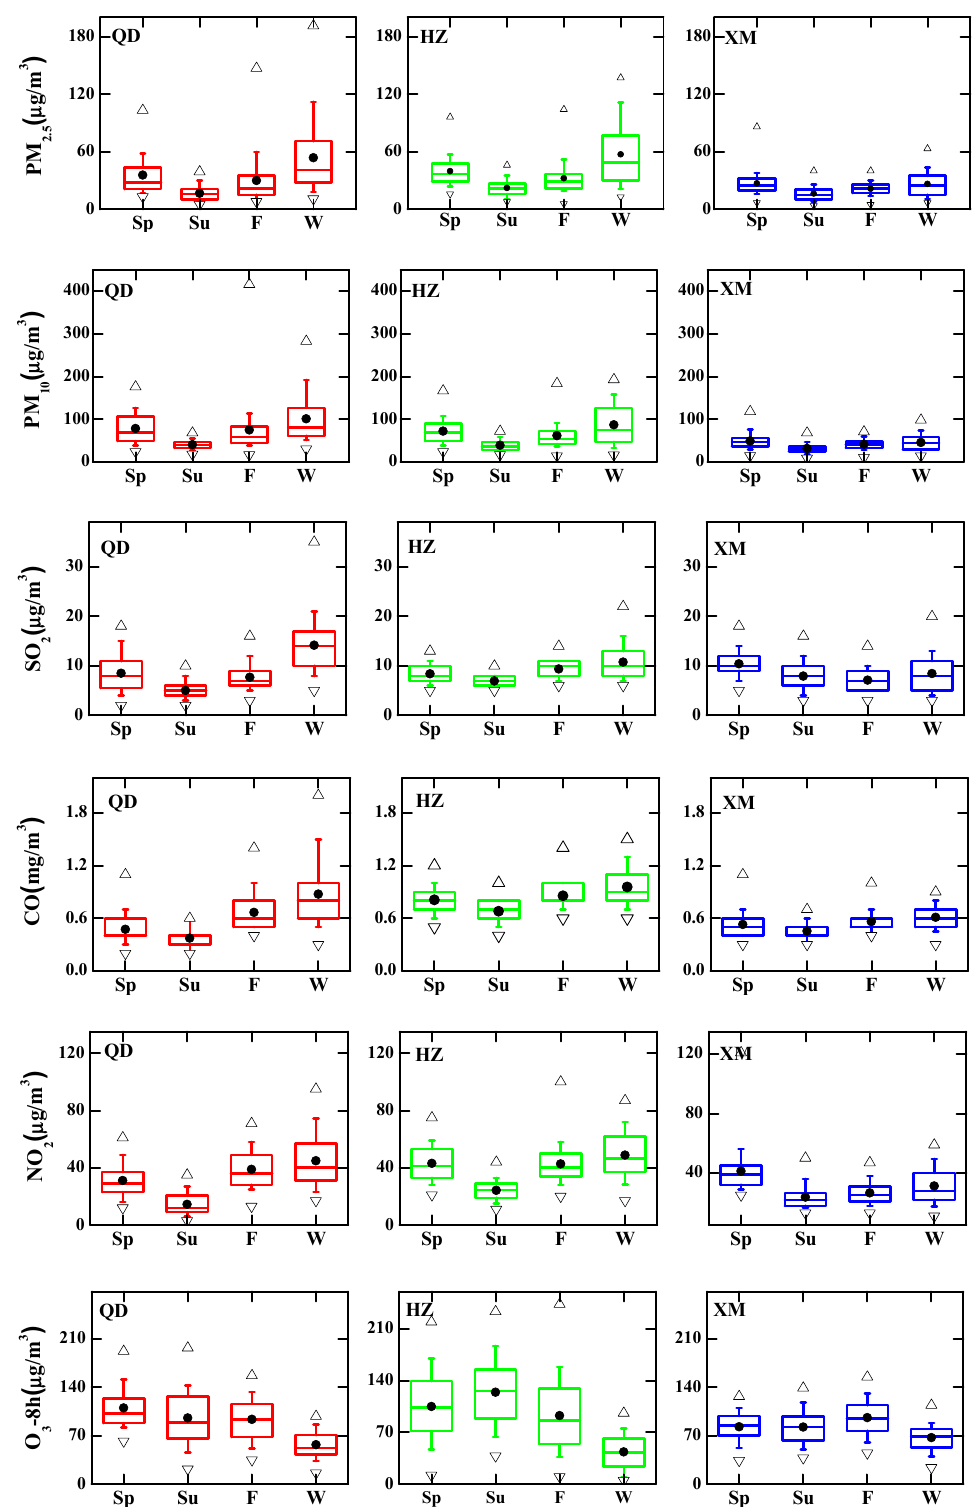
Figure 7. Seasonal variations of six pollutants in Qingdao (QD), Hangzhou (HZ) and Xiamen (XM) during 2018 (Sp, Su, F, and W indicate spring, summer, fall, and winter, respectively). The top and bottom whiskers show the 90th and 10th percentile while the upper and lower boundaries of the central box show 75th and 25th percentile. The middle line of the box represents median, the solid circle represents the arithmetic average, the positive triangle and inverted triangle represent max and min values, respectively.